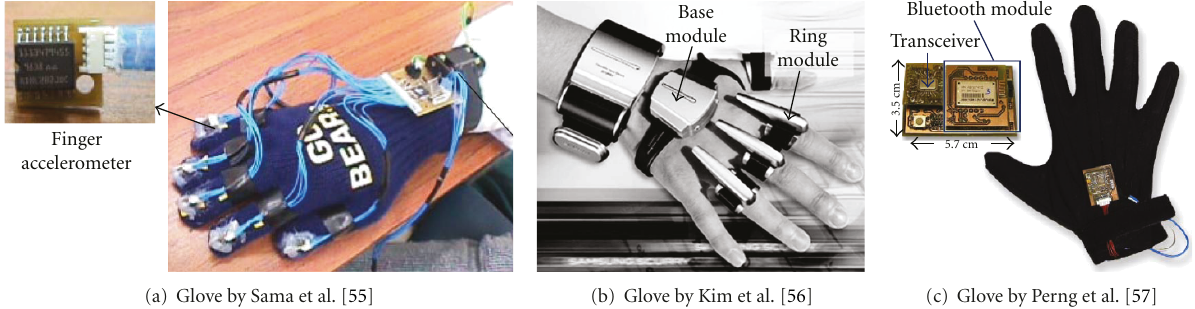
Figure 15: Examples of the glove like input devices with built-in